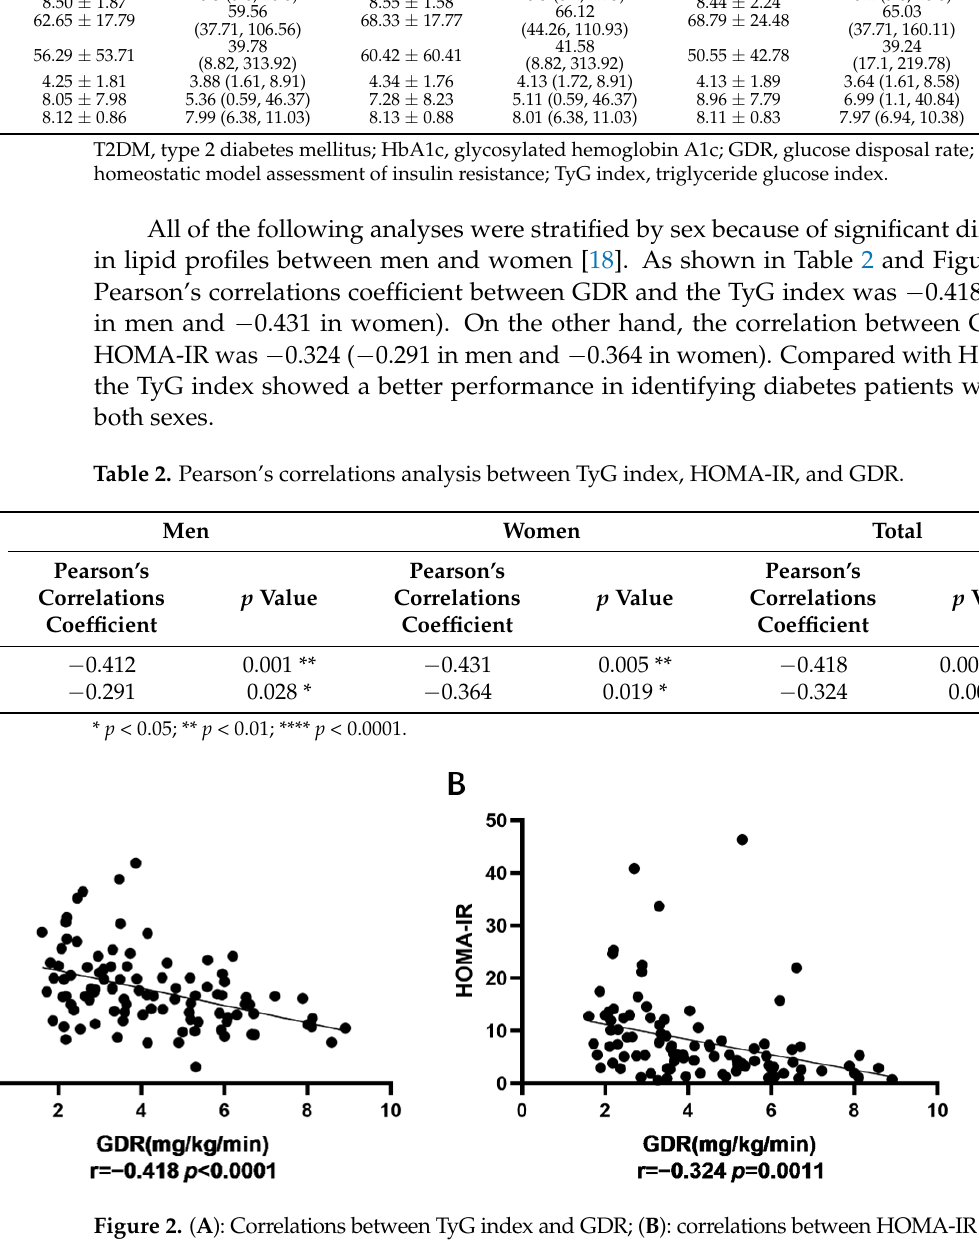
Figure 2. ( A ): Correlations between TyG index and GDR; ( B ): correlations between HOMA-IR and GDR.